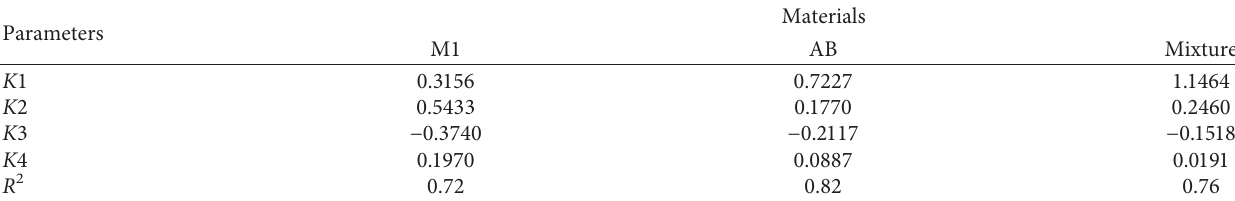
Table 5: Parameters of the PD model of the studied materials.